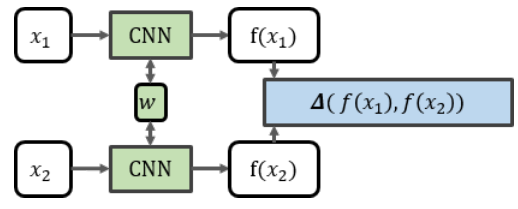
Figure 2. Siamese architecture. Two images are propagated through the same CNN architecture. Both CNNs share their weights w . The L2 distance ∆ of the resulting feature vectors f ( x 1 ) , f ( x 2 ) is used to calculate the training loss. weights and, thus, the relative size of Y and (1 − Y ) will indi- cate an equilibrium distance that minimizes the loss. The larger